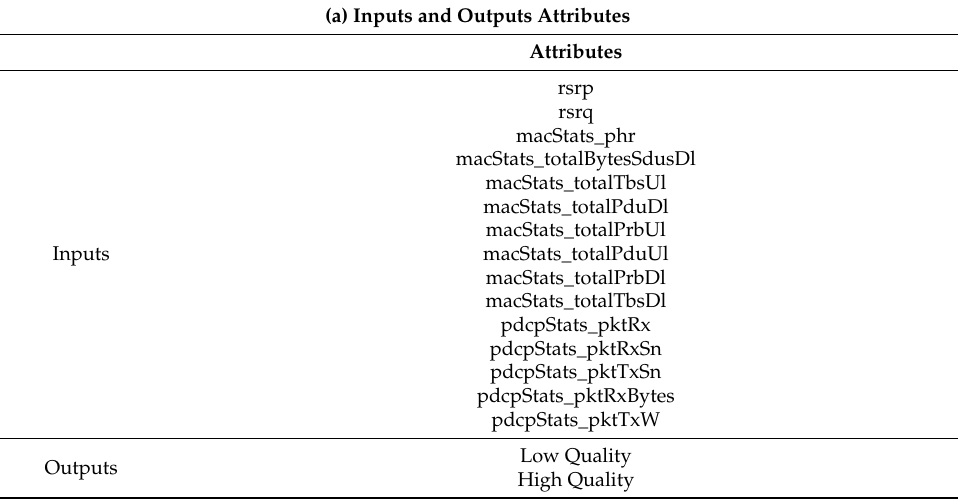
Table 1. Inputs and Outputs Attributes of the ML models and the Proposed CQI